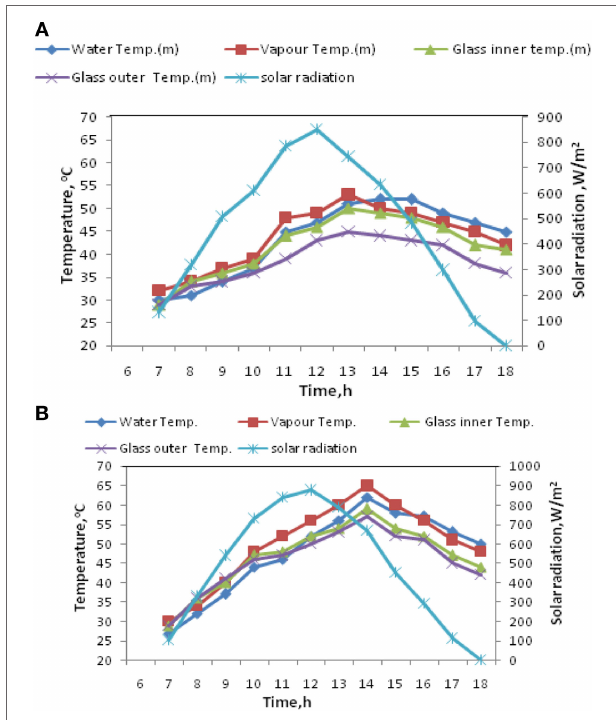
FIGURE 4 | Hourly profile of solar radiation with various temperatures. (A) Modified solar still. (B) Conventional solar still.